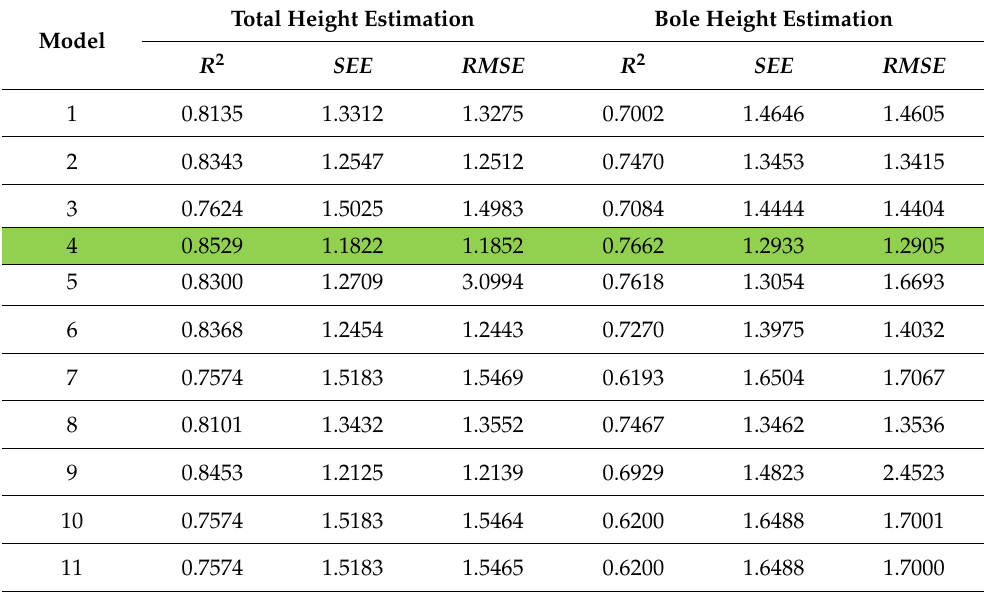
Table 4. Values for the comparison criteria for selecting the height–age model. Total Height Model